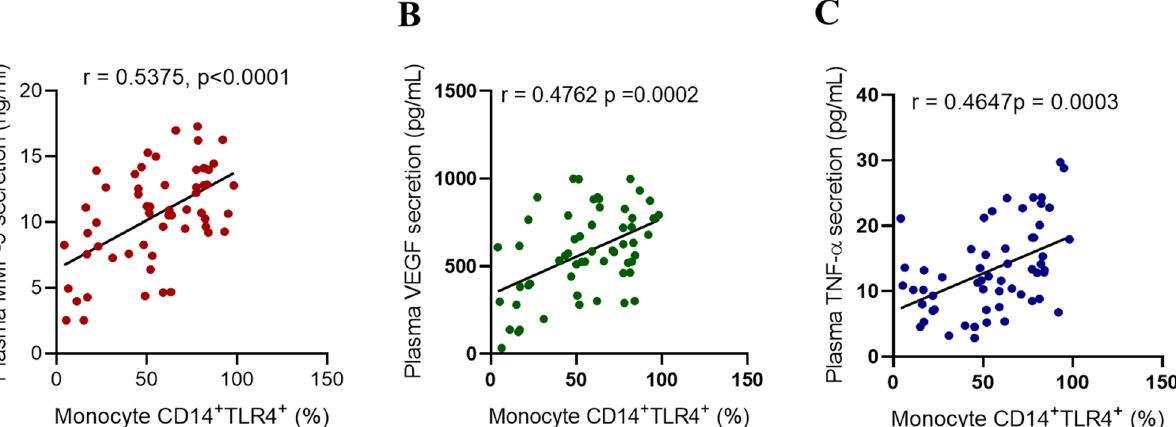
Figure 3. CD14 + TLR4 + monocytes are associated with obesity related-inflammatory markers in the plasma. Pearson’s correlation coefficient analysis was conducted to investigate the association between monocyte TLR4 expression and plasma levels of obesity related cytokines secretion of MMP-9 ( A ), VEGF ( B ) and TNF-α ( C ). All data are expressed as mean ± SD. P ≤ 0.05 was considered statistically significant (*P < 0.01; **P < 0.001, ***P < 0.0001).